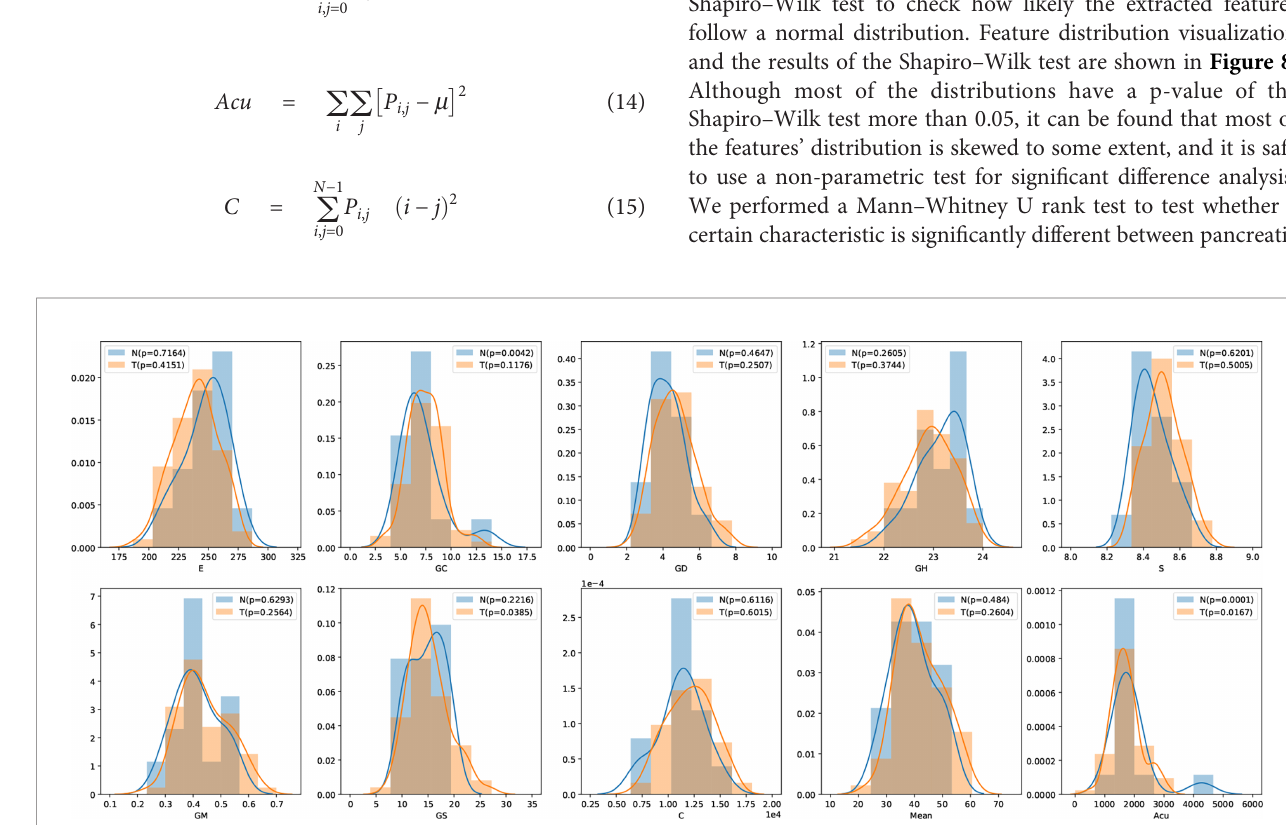
FIGURE 8 | Feature distribution visualization. N represents the group of normal subjects, and T represents the group of pancreatic tumor patients. p value is the results of Shapiro – Wilk